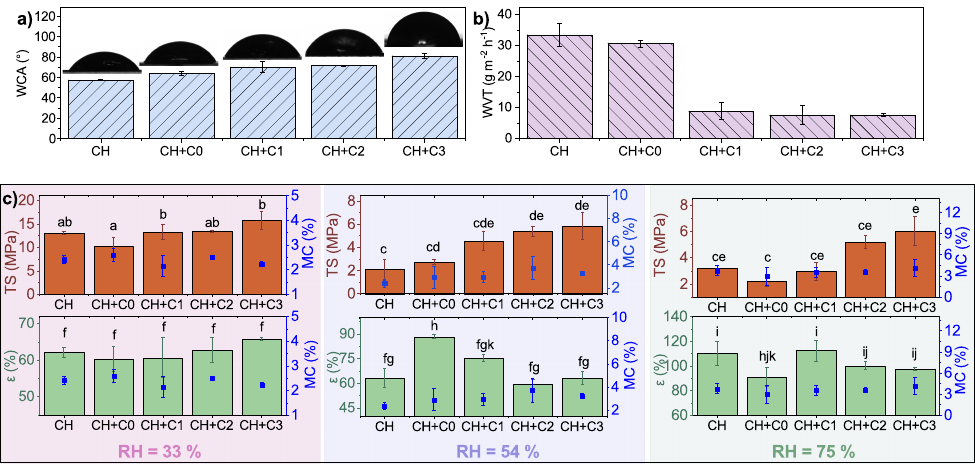
Figure 6. ( a ) Water contact angle (WCA), ( b ) water vapour transmission (WVT) and ( c ) mechanical properties with respect to environmental RH of chitosan-based films, where different letters denote samples with significantly different mean value ( p <